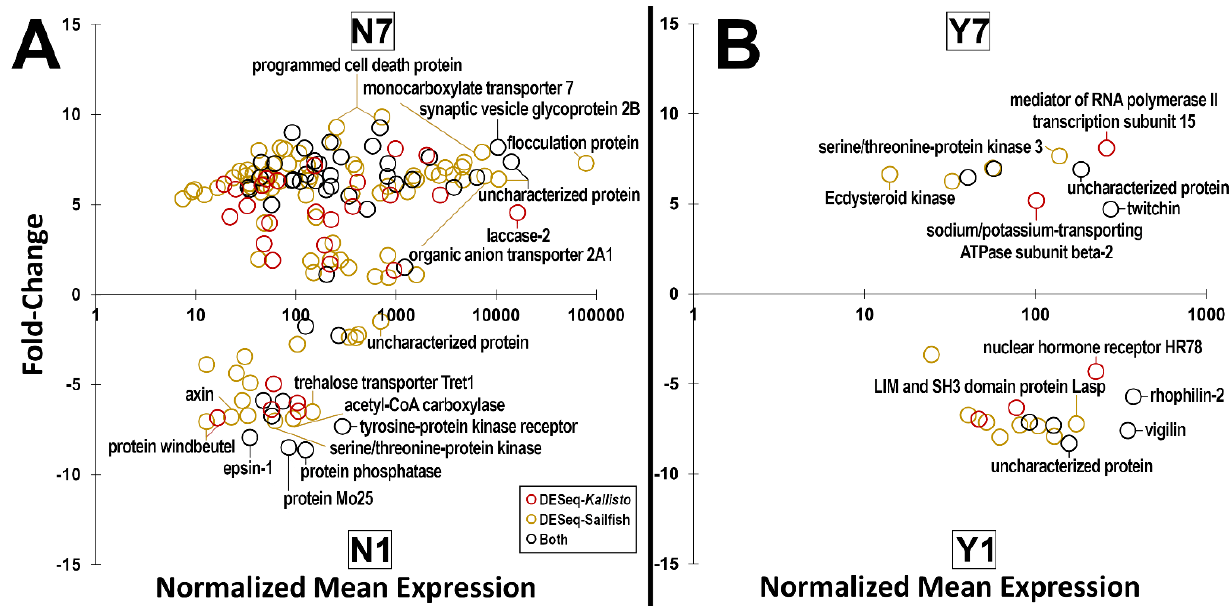
Figure 2. Log2 fold-change comparisons and median-of-ratios normalized mean expression averages across all samples for all differentially expressed genes identified by DESeq2 pipelines. ( A ), comparison between the non-bloodfed/dehydrated group over the non-bloodfed/non-dehydrated group (N7_N1); ( B ), comparison between the bloodfed/dehydrated group over the bloodfed/non- dehydrated group (Y7_Y1). Yellow circles denote genes that were identified through the DESeq- Sailfish pipeline; red circles, DESeq-Kallisto pipeline; and black circles were genes identified by both pipelines, with the highest mean expression pipeline used. Significantly expressed transcripts are included in Supplementary Table S1 and sample-specific normalized mean expression values are included in Supplementary Table S5.